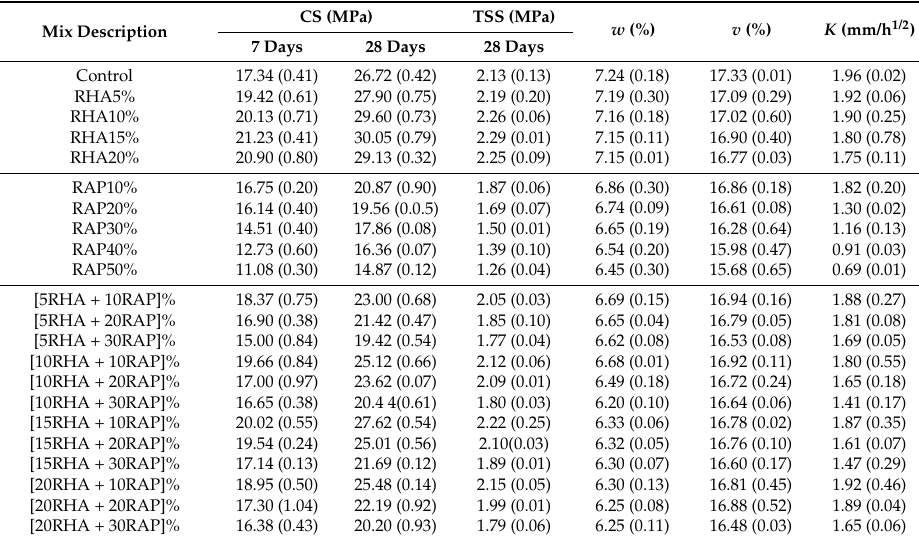
Table 9. Hardened properties of concrete.